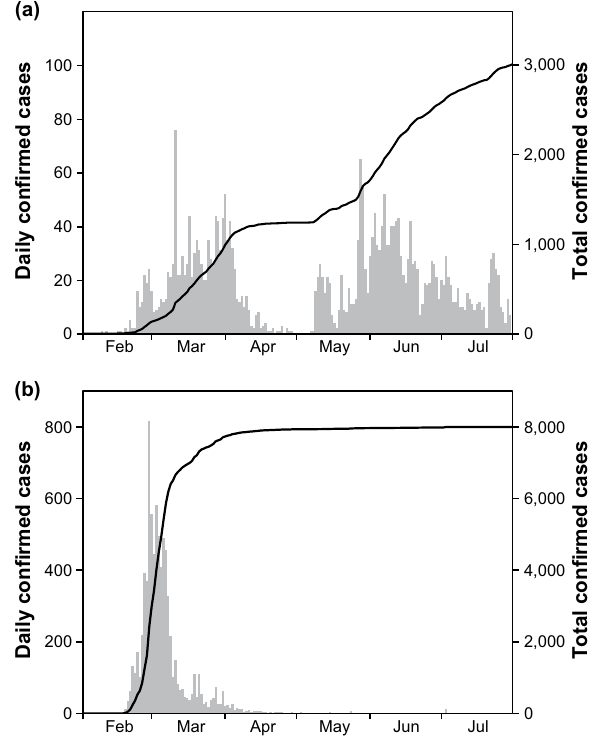
Figure 1. Daily confirmed cases (gray box) and total confirmed cumulative cases (solid line) of COVID-19 in Seoul metropolitan region ( a ) and Daegu-Gyeongbuk region ( b